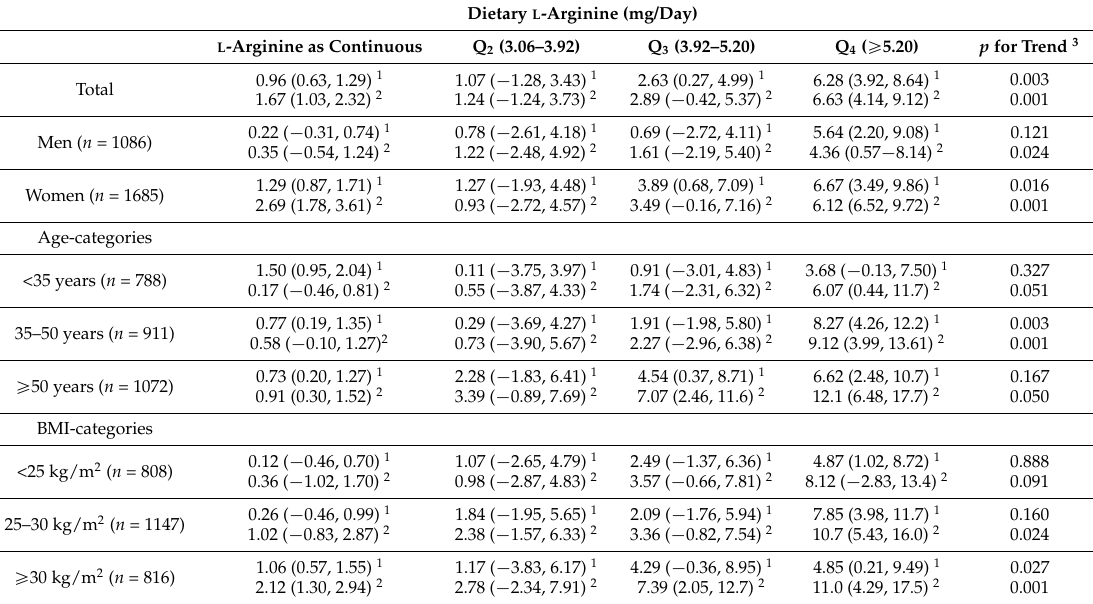
Table 3. The association of dietary L -arginine intakes and serum NOx according to sex and age groups. Dietary L -Arginine